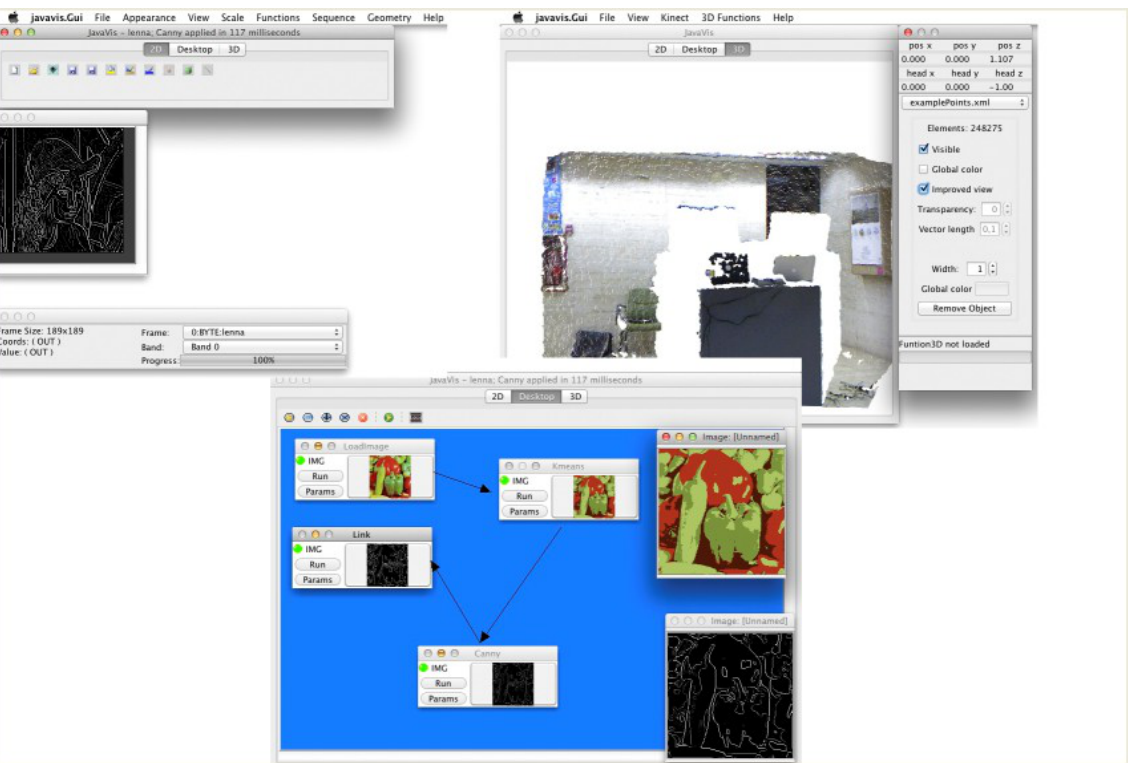
Figure 1. GUI for JavaVis. Lef, JavaVis2D; botom, JavaVisDesktop; right,